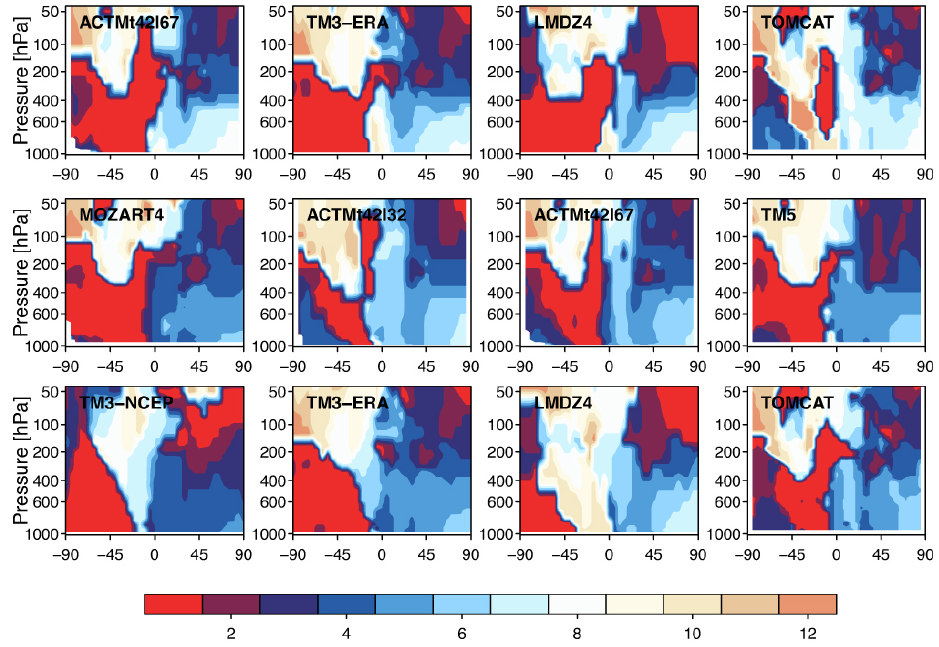
Fig. 7. Month of minimum in CFC-12 (upper panel) and N 2 O (middle and lower panel) shown for each model (the subplots) in 2007.